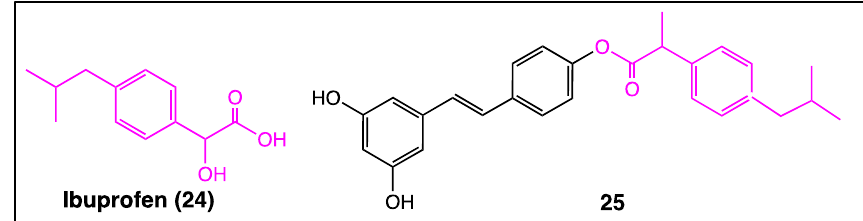
Figure 13 . Structure of ibuprofen ( 24 ) and resveratrol-ibuprofen hybrid compound 25.